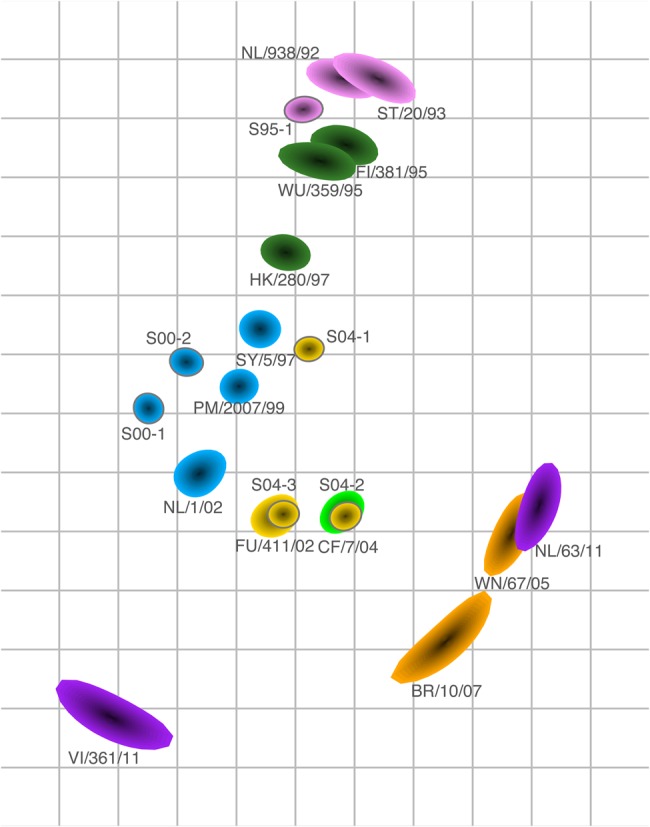
Antigenic map based on the hemagglutination inhibition (HI) titers of the sera of the 6 high responders and representative virus isolates of different antigenic clusters [1]. In an antigenic map, both vertical and horizontal axes represent antigenic distance. The spacing between grid lines is 1 antigenic unit distance, corresponding to a 2-fold dilution in the HI assay (eg, 2 units correspond to a 4-fold dilution, and 3 units correspond to an 8-fold dilution). Different antigenic clusters are indicated with different colors as in Figure 1. Sera are shown with a gray outline, and serum names indicate the season of serum collection (eg, specimen S95-1 was collected in 1994–1995). The size and shape of each symbol reflects the certainty in positioning of the virus or serum and represents the coordination confidence area as locations on the map that the point could also occupy without increasing the stress of the map with >0.5. The shape size typically increases as fewer HI titers are available. This map was made without a minimum column basis.